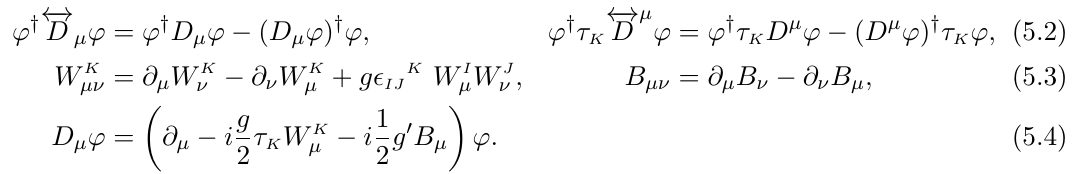
Table 7 . Limits on the Wilson coe(cid:14)cients C i [TeV (cid:0) 2 ] for the SMEFT operators listed in table 6. consider is given in table 6, where the following conventions are